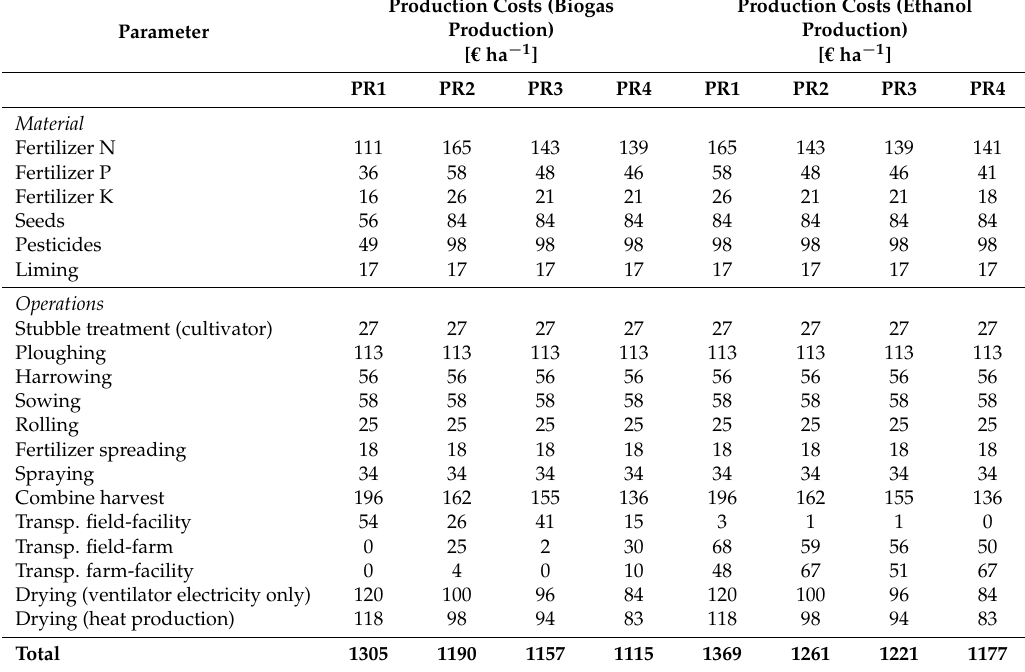
Table A10. Feedstock production costs [ € ha − 1 ] for winter wheat grains in the different production regions (PR) for the production of biogas and ethanol.